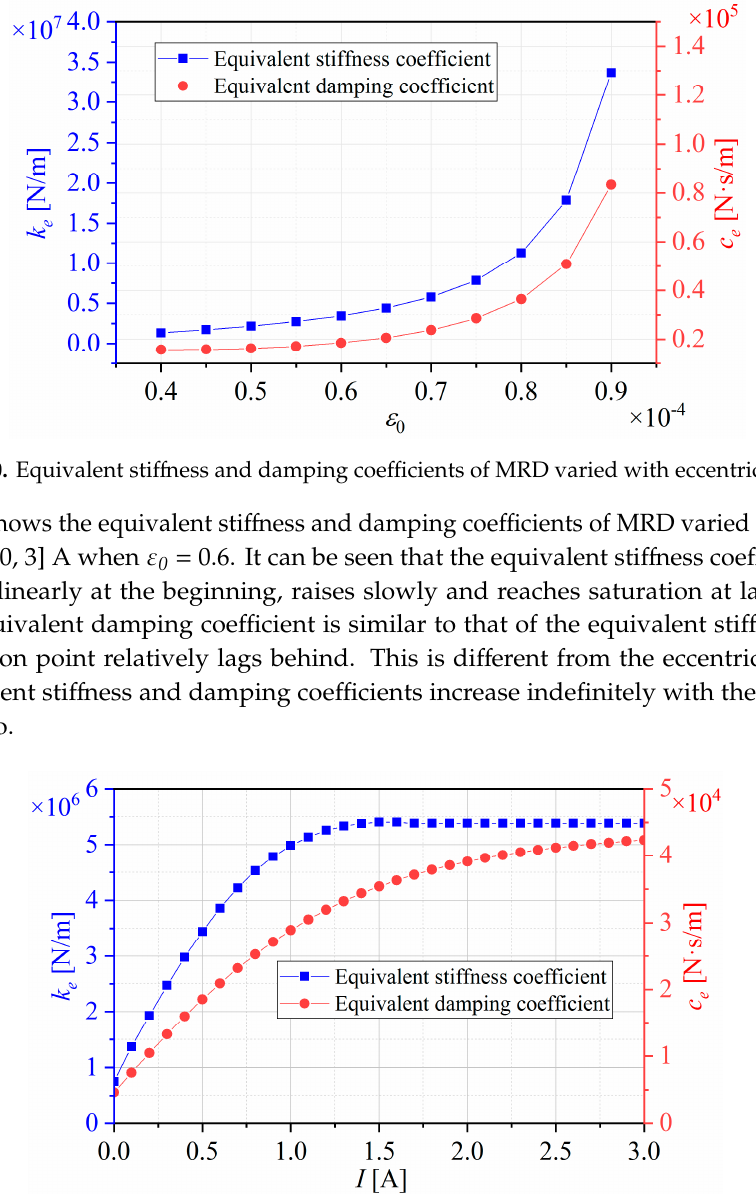
( d ) Figure 9. Three-dimensional graphs and contour maps of the film pressure distribution under several currents. ( a ) I = 0 A; ( b ) I = 0.5 A; ( c ) I = 2 A; ( d ) I = 3 A. Figure 10 shows the equivalent stiffness and damping coefficients of MRD varied with eccentricity ratio 0 ε in the range of [0.4, 0.9] when I = 0.5 A. It can be found that with the increase of